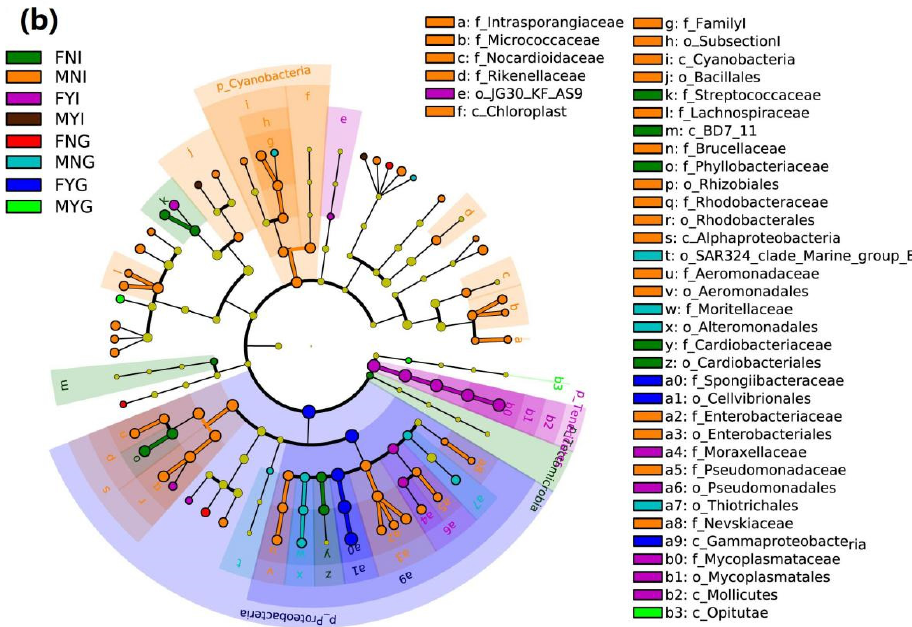
Figure 6. Inter-group variation of intestinal and gill tissues of dwarf-form squid. ( a ) LDA score; ( b ) LEfSe cladogram.